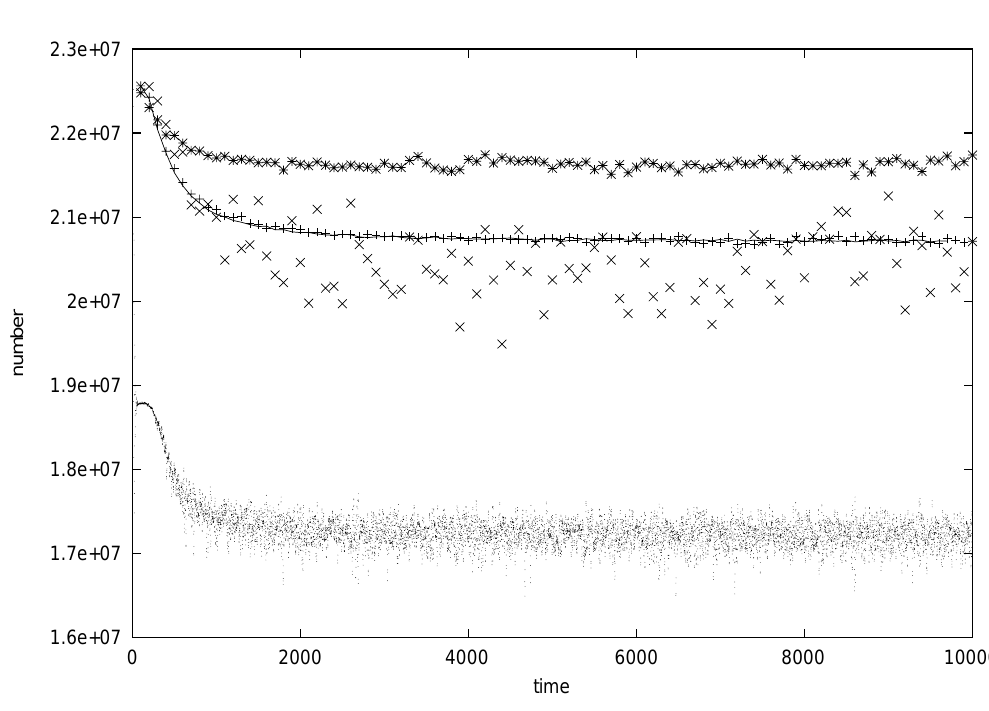
Fig. 3 – Comparison of populations, versus number of iterations or “years”, for (from below) SX, AP, MP. The highest data refer to a mixture of HA and MP with µ = 4; nearly the same results are obtained for µ = 3 and 5. The data for AS (line) overlap with those of MP (+), while AP(x) fluctuates around slightly lower values. For SX we show the sum of males and females. Threshold T = 9, 4 births per year and per female above minimum reproduction rate of 8, one mutation per string of 32 bits at birth, N max = 80 million is about four times larger than the actual